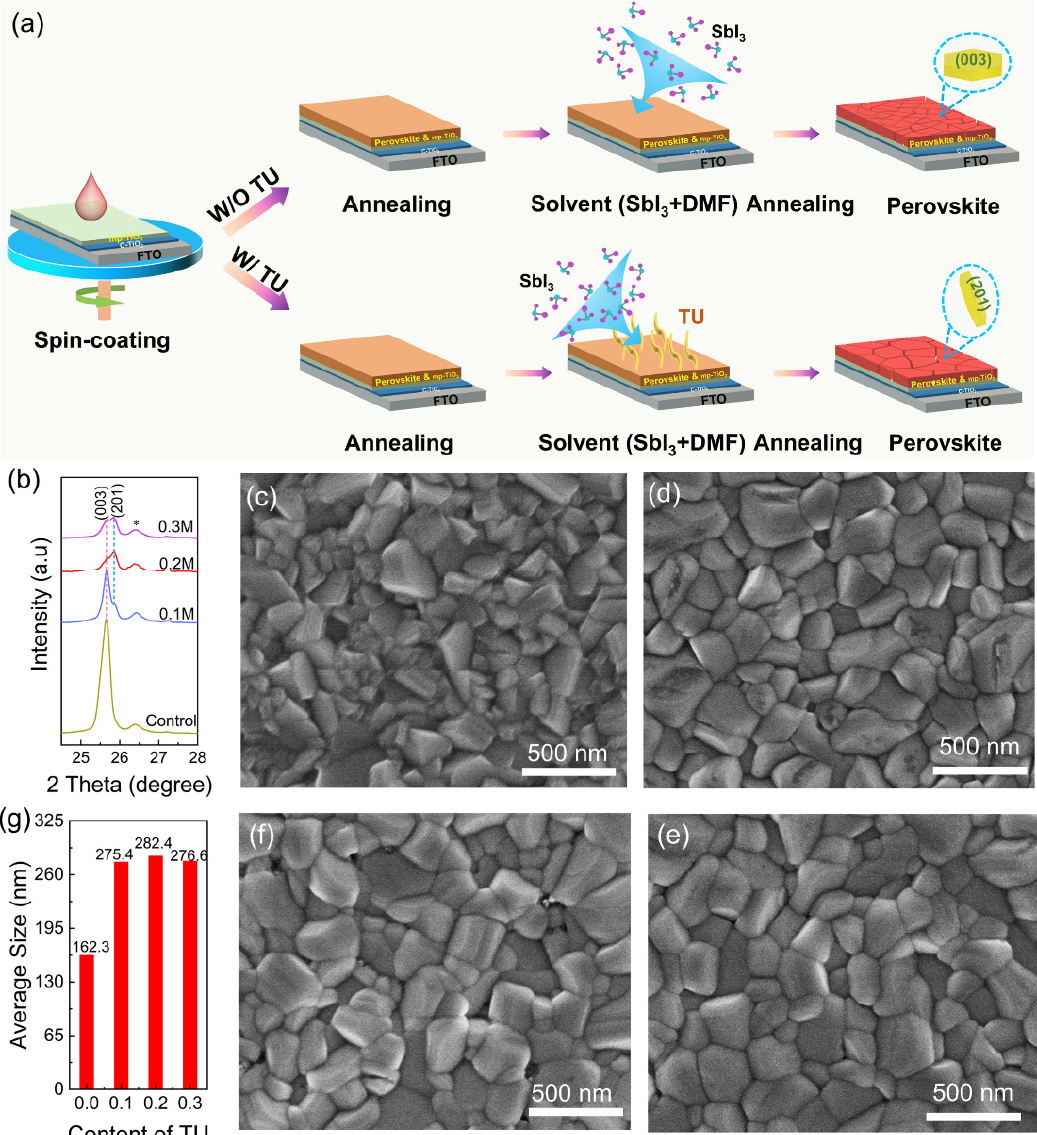
Figure 1. ( a ) Illustration of the Sb-based perovskite film fabrication procedure. ( b ) XRD patterns of the prepared Cs 3 Sb 2 I 9 − x Cl x film with various amounts of TU. The XRD peak of “*” symbols belong to the TiO 2 /FTO substrates. ( c – f ) SEM of the control, 0.1, 0.2 M TU, and 0.3 M additive Cs 3 Sb 2 I 9 − x Cl x films. ( g ) The grain size statistical distribution of the control, 0.1M, 0.2M, and 0.3M TU additive Cs 3 Sb 2 I 9 − x Cl x films.